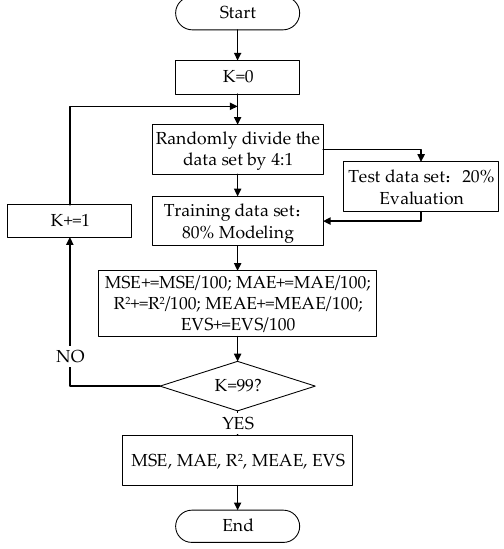
Figure 2. Model evaluation process.